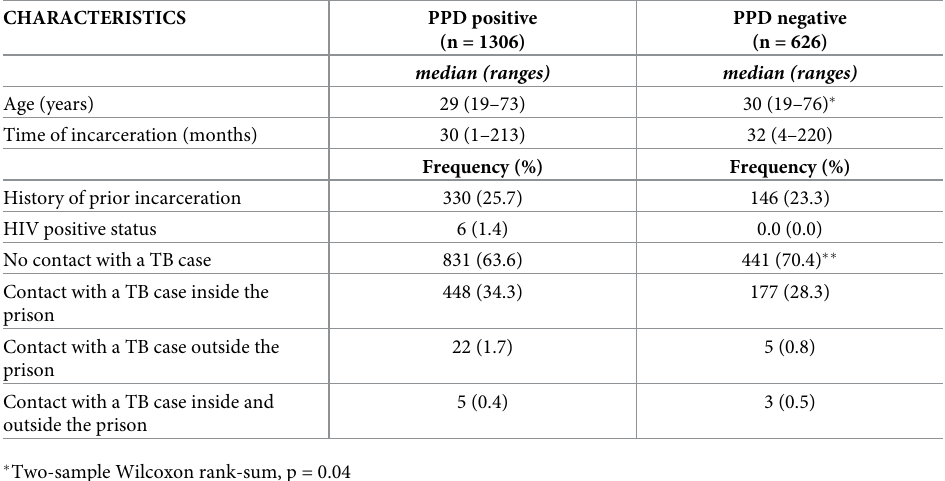
Table 1. Baseline characteristics of inmates with positive and negative TST